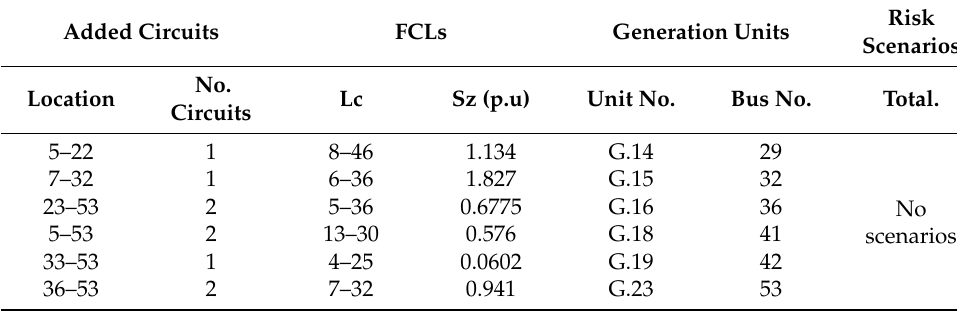
Table 5. Configuration of WDN using the proposed approach without N-1 reliability.